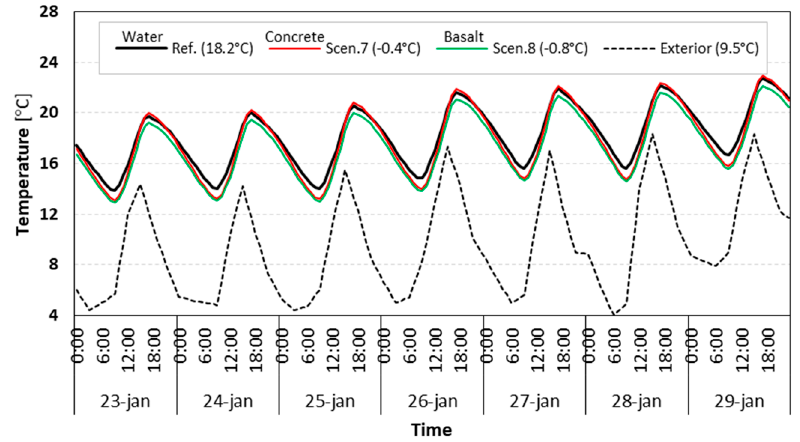
ff erent thermal storage Figure 16. Influence of different thermal storage materials. Figure 16. Influence of di